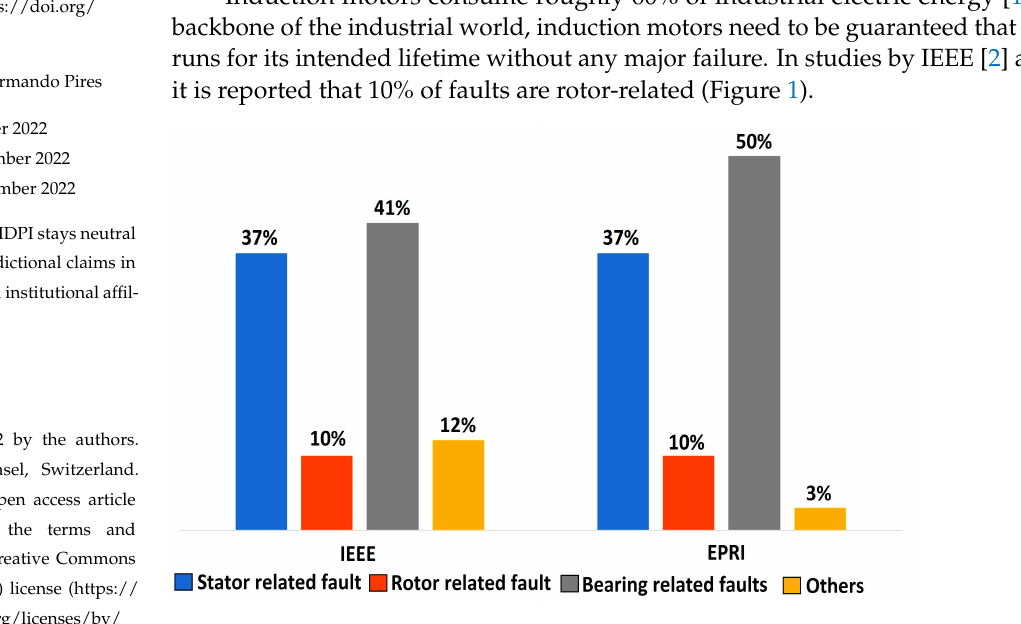
Figure 1. Common motor